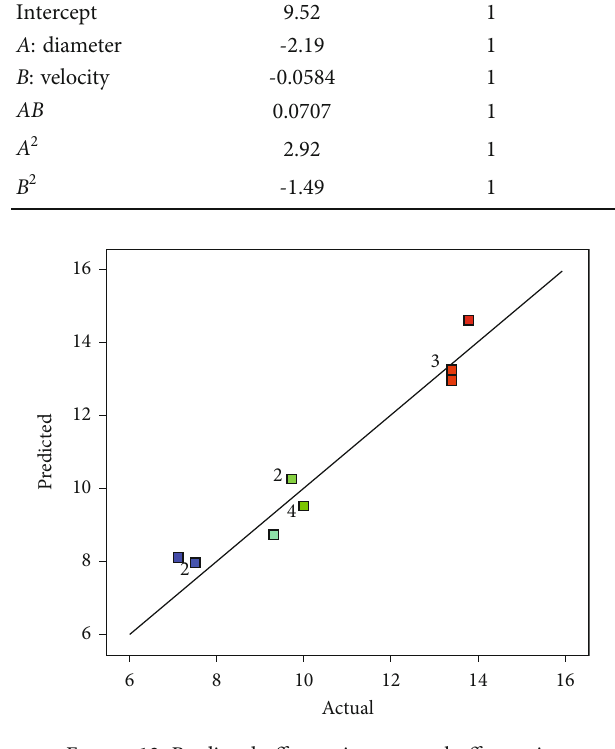
Figure 12: Predicted o ff set ratio vs. actual o ff set